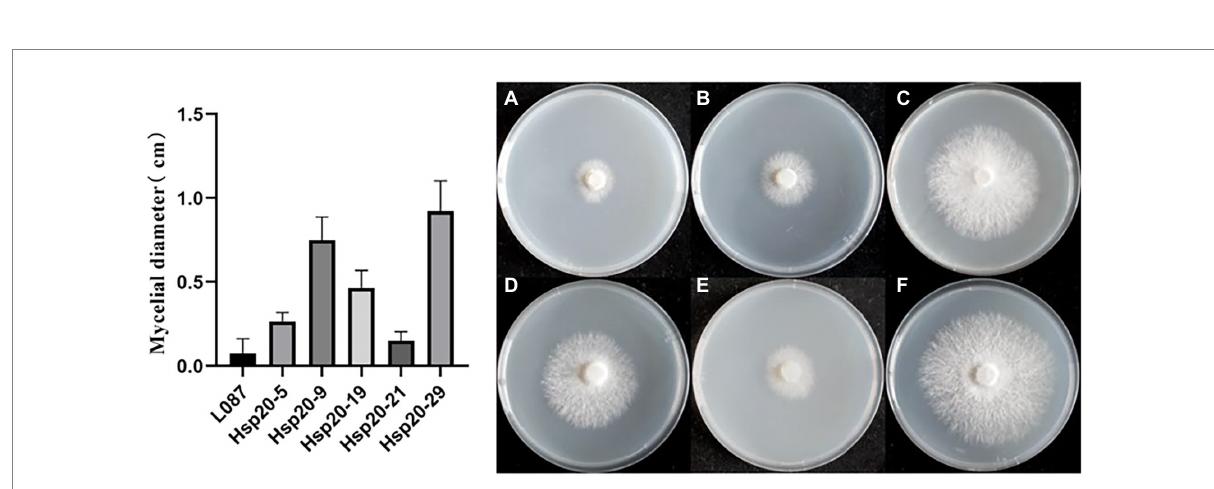
FIGURE 11 The growth of transformants after heat treatment. (A) L087, (B) hsp20-5, (C) hsp20-9, (D) hsp20-19, (E) hsp20-21, and (F)